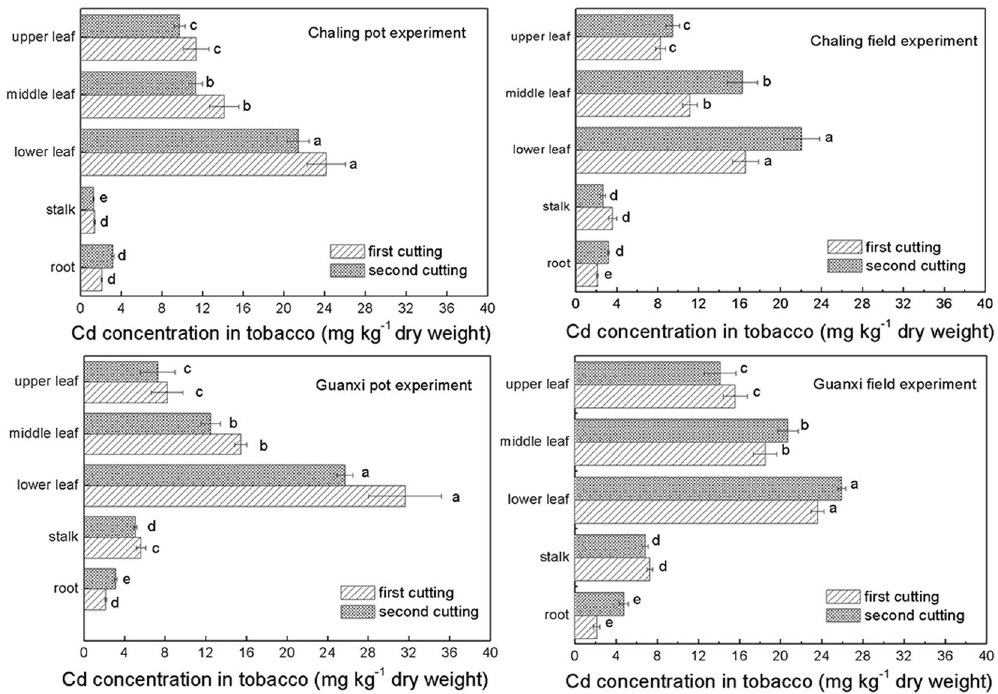
Figure 1. Cd concentrations in tobacco grown in pot and field experiments. Values are means ± SE for nine replicates, while different letters indicate significant differences between root, stalk, lower leaf, middle leaf, and upper leaf of tobacco according to Duncan’s multiple range test at P ≤